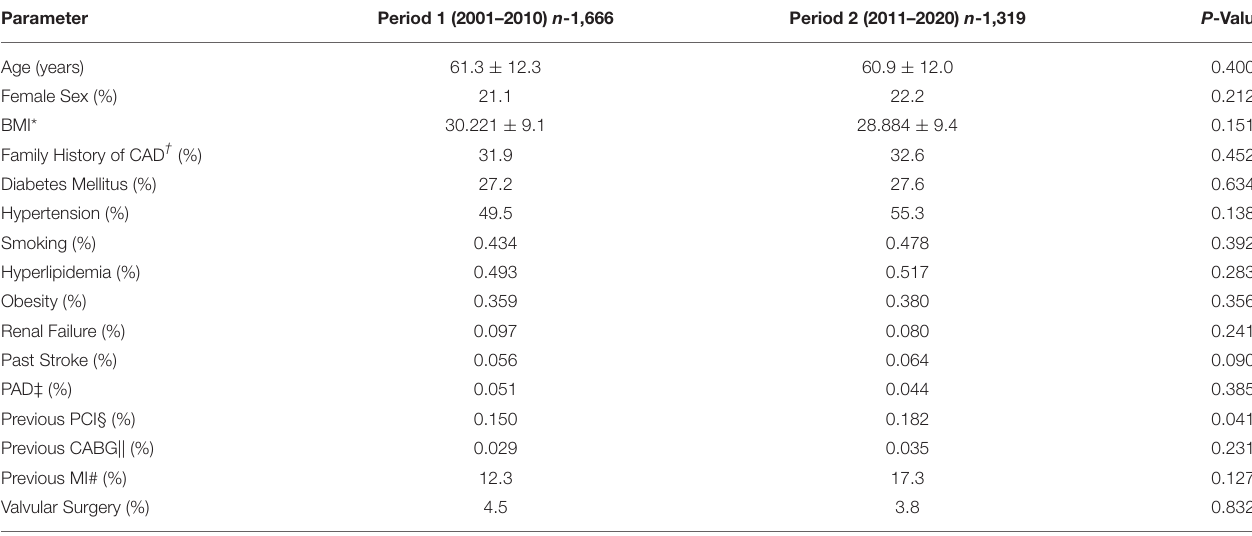
TABLE 1 | Baseline characteristics according to decade.